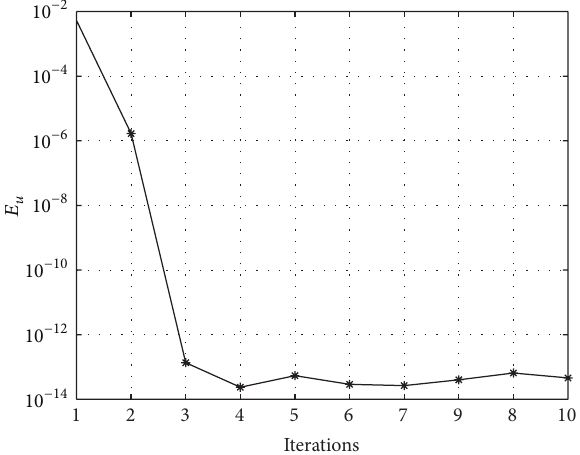
Figure 16: Burgers-Huxley equation convergence graph.